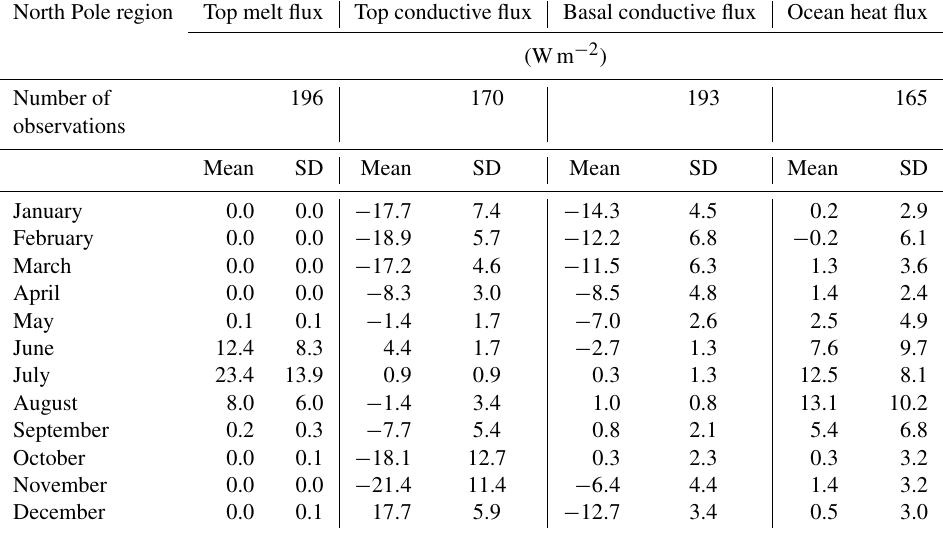
Table 2. Means and standard deviations of fluxes measured from the IMB data in the North Pole region (in Wm − 2 ), in each month of the year. For each flux, the convention is that downwards is positive.